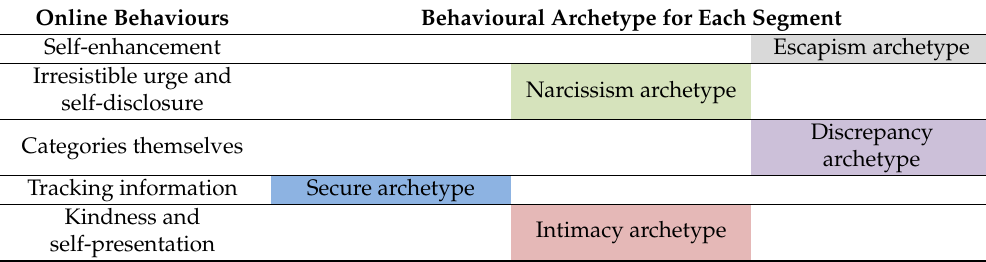
Table 2. Five users’ behavioural archetypes: initial